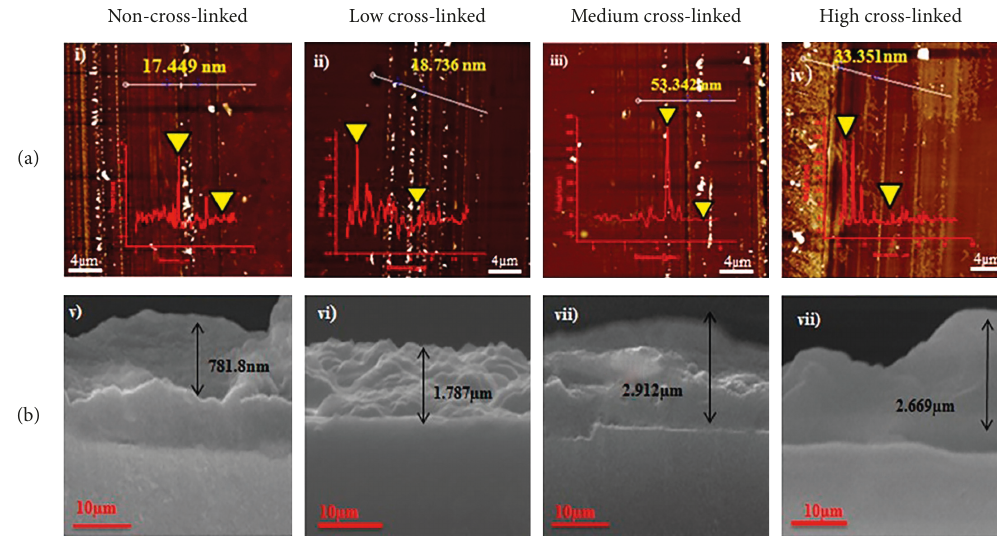
Figure 7: Film thickness representation before and after mineralization. (a) AFM of film thickness before mineralization of (PAH/ PAMAM) 7.5 and (b) SEM cross section of the films after mineralization of (PAH/PAMAM) 7.5 -CaCO 3 . Table 3: Elastic moduli ( E ) of the Si substrate and synthesized (PAH/PAMAM) 7.5 films before and after mineralization. Film stiffness, E (GPa) Noncross-linked Low cross-linked